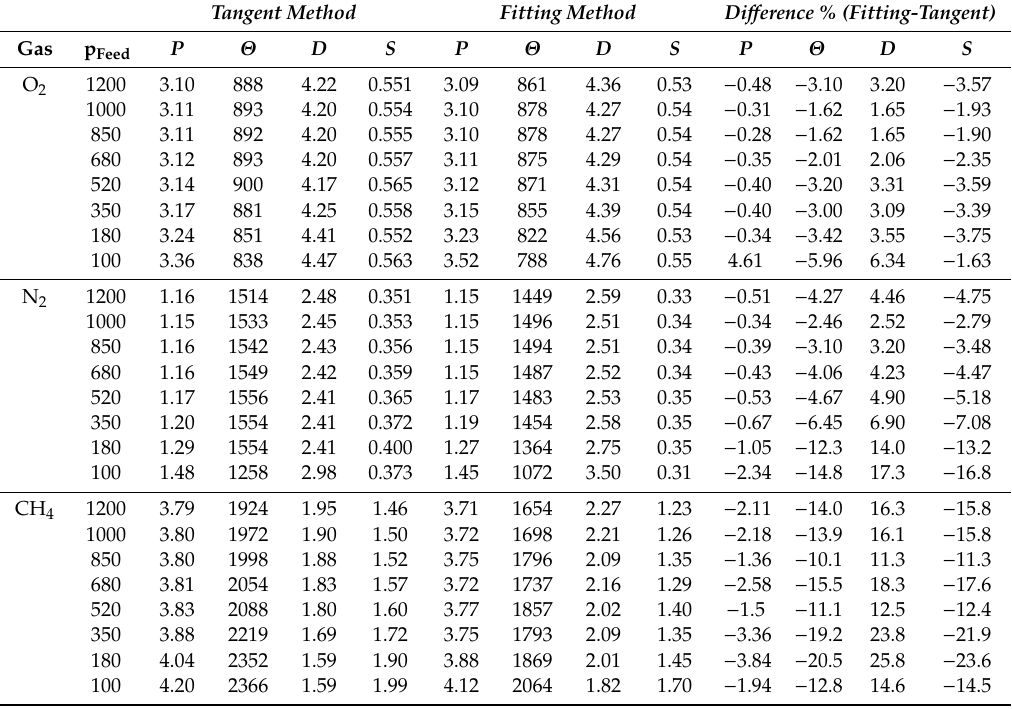
Table A1. Permeability [Barrer], Θ [ s ], Di ff usion coe ffi cient [10 − 12 m 2 s − 1 ] and Solubility [ cm 3 STP cm − 3 bar − 1 ] of the Pebax ® 1657 / Cu II 2 (S,S)-hismox · MMM at 25 ◦ C and di ff erent feed pressures [mbar] determined by the tangent and the fitting methods (single Time Lag), as well as their % di ff erence. Tangent